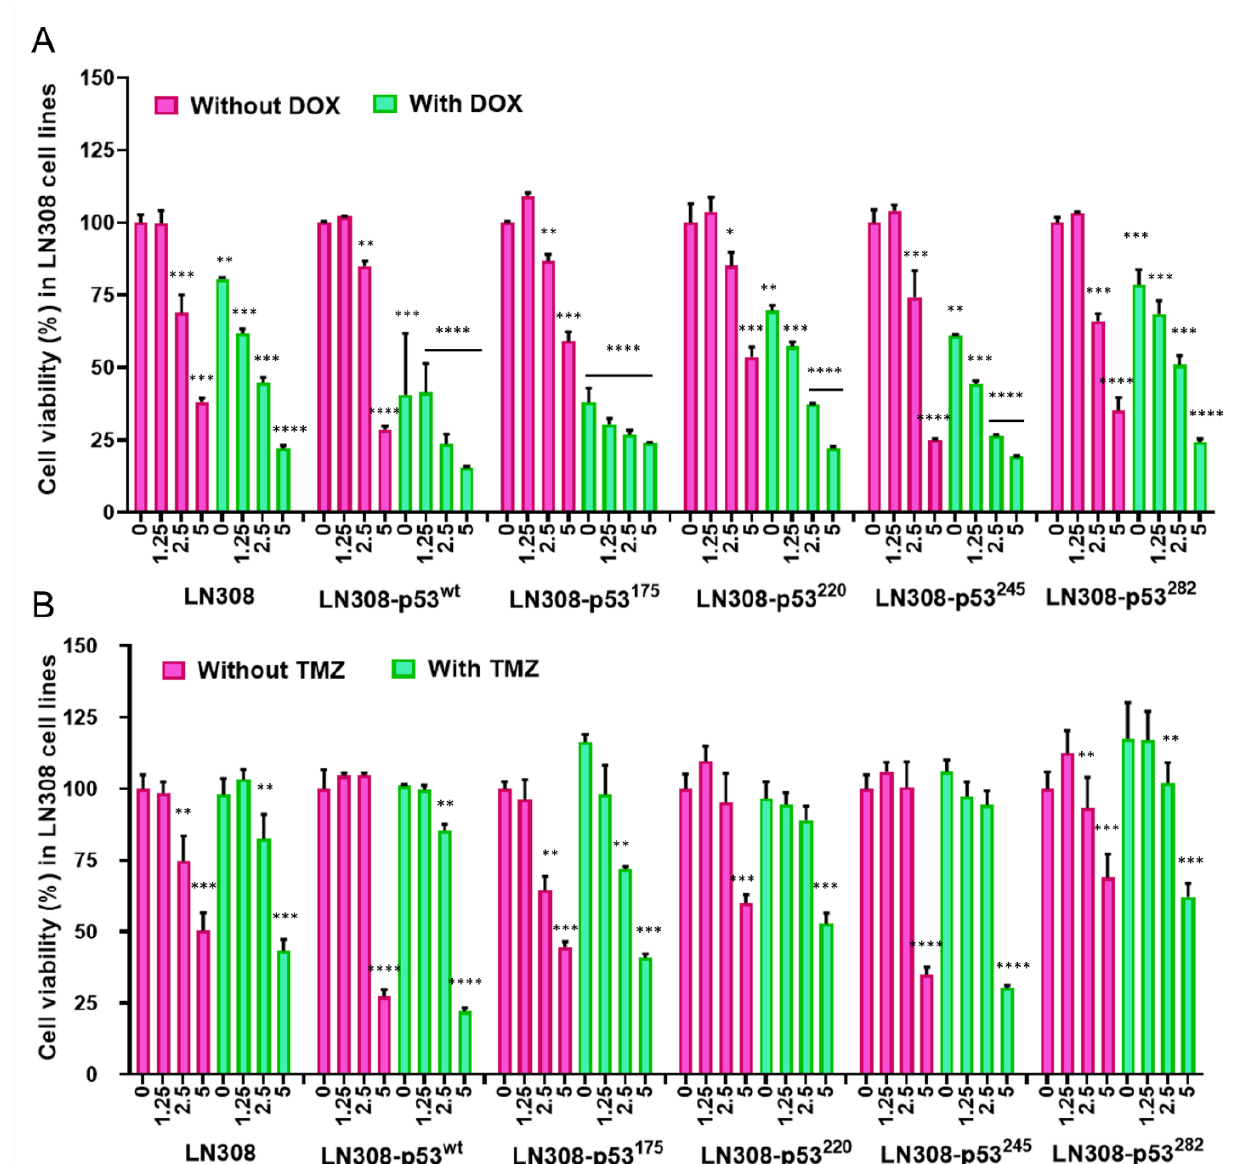
Figure 6. MTT assay result shows that co-treatment of CET-CH-6 with DOX and TMZ inhibits cell growth in LN308 cell lines with different p53 variants. Differential therapeutic responses of LN308 cells stably expressing different p53 variants as assessed using MTT in response to co-treatment with ( A ) CET-CH-6 and DOX, and ( B ) CET-CH-6 and TMZ. Each sample was normalized to the untreated control. Experiments were performed three times, and error bars represent mean ± SD. *, **, ***, **** represent p -value < 0.05, <0.01, <0.001, <0.0001, respectively. Samples were assayed 72 h post treatment. Each sample was tested against the untreated control.